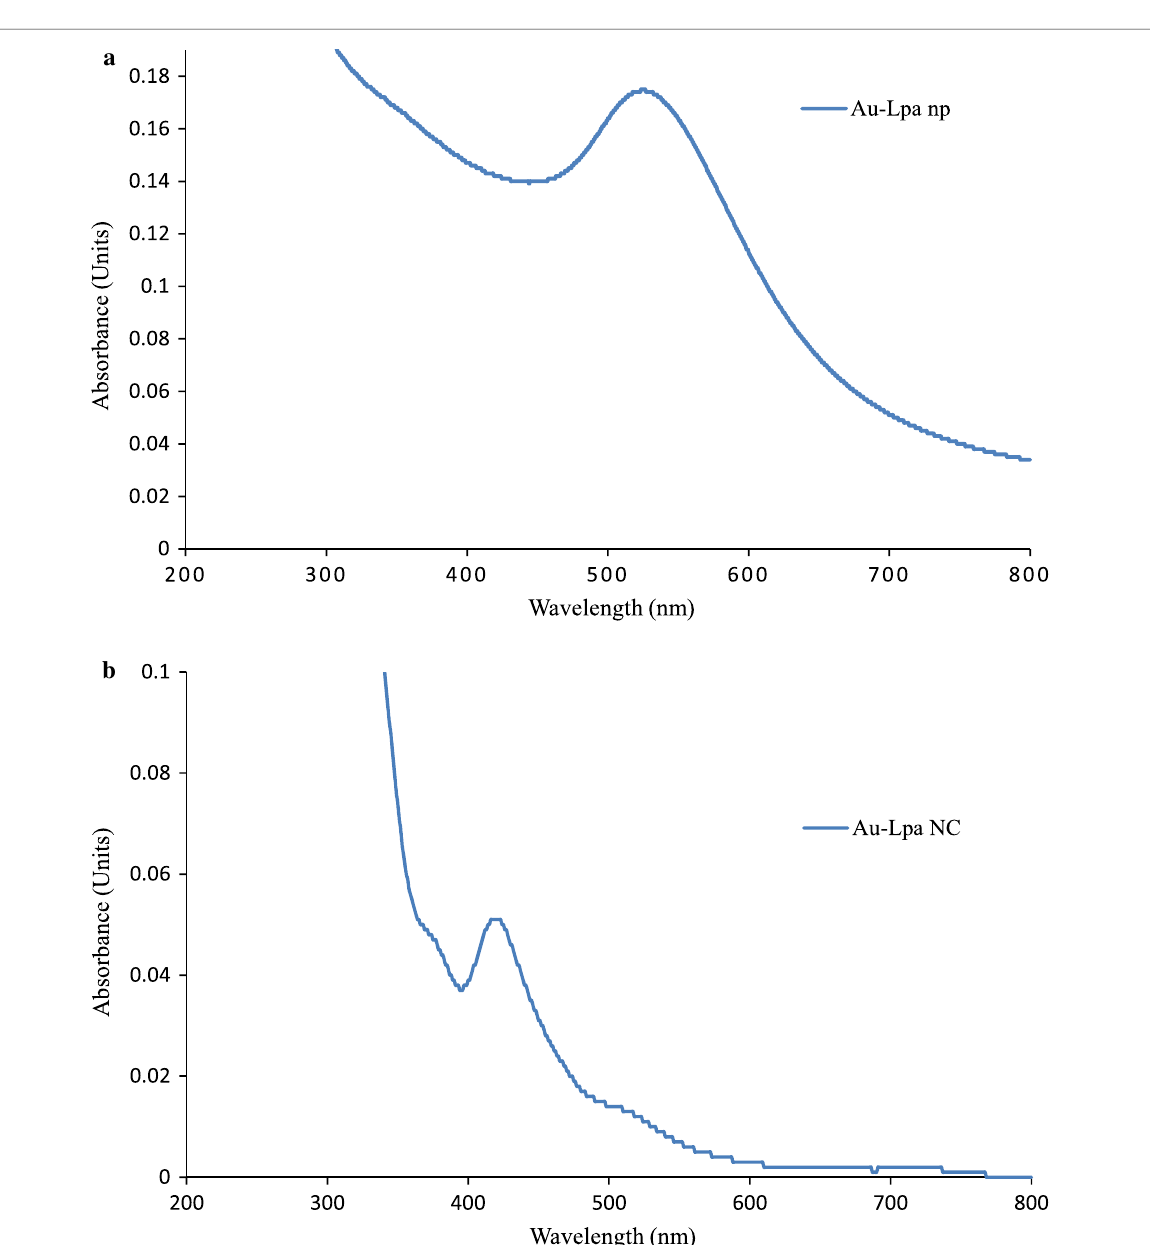
Fig. 1 UV–visible spectrum of Au-LPa nanomaterials. a Au-LPa large show surface plasmon resonance band at 524 nm. b Au-LPa small show char- acteristic absorption signal at 418